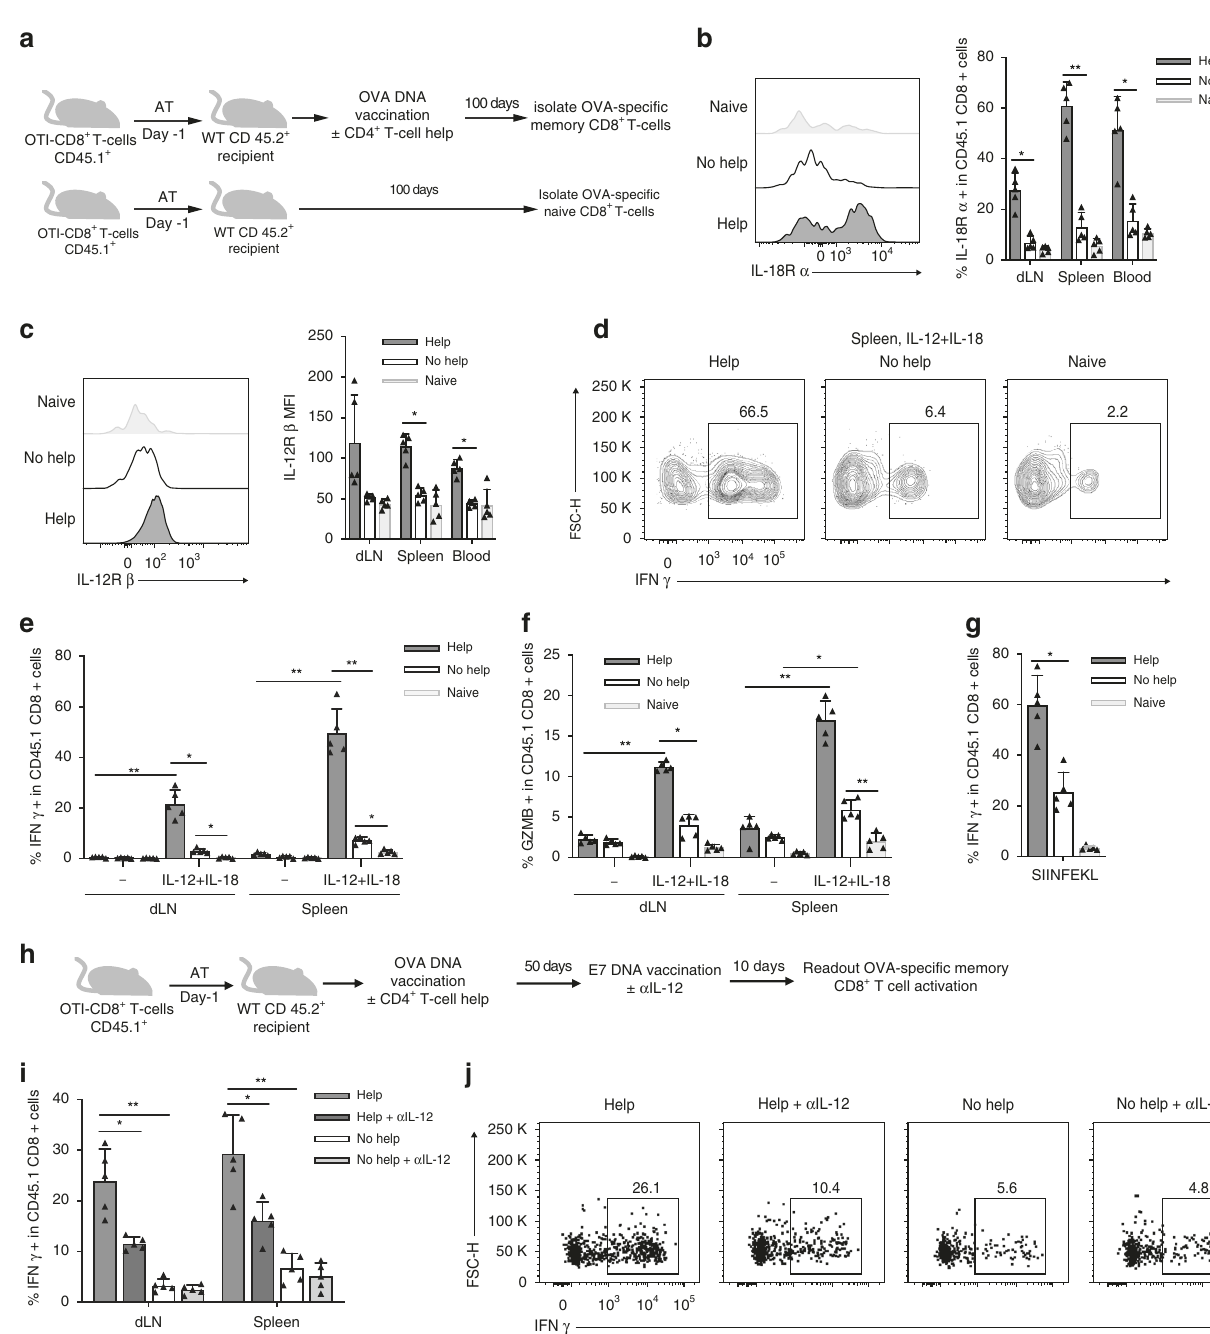
Fig. 4 CD4 + T cell help promotes innate recall function of memory CD8 + T cells. a Experimental set up. CD45.1 + OT-I T cells were adoptively transferred into CD45.2 + recipient mice ( n = 5 per group) that 1 day later received OVA-encoding Help or No Help pDNA vaccine. At day 100 after primary vaccination, fl ow cytometry was performed in blood and CD45.1 + OT-I T cells were fl ow cytometrically isolated from dLN and spleen and directly analyzed or incubated for 5 h with IL-12 and IL-18 or OVA peptide. Unvaccinated recipient mice were used to isolate naïve OT-I T cells. b Representative fl ow cytometric plots (left panel) and percentage of IL18-R α expressing cells within CD45.1 + OT-I cells in indicated organs (right panel). c Representative fl ow cytometric plots (left panel) and MFI of IL-12R β expressed on CD45.1 + OT-I T cells in indicated organs (right panel). d – g Primary fl ow cytometric data ( d ) and frequencies of IFN γ -producing ( e , g ) or Granzyme B (GZMB)-producing ( f ) OT-I T cells in dLN and spleen, as determined after in vitro stimulation with IL12 + IL-18 (D-F) or OVA peptide (SIINFEKL) ( g ). h Experimental set up. CD45.1 + OT-I T cells were adoptively transferred into CD45.2 + recipient mice ( n = 5 per group) that 1 day later received OVA-encoding Help or No Help pDNA vaccine. At day 50 after primary vaccination, mice were rechallenged with E7-encoding Help vaccine and injected with isotype control or neutralizing mAb to IL-12, 4 times, every 3 days. At day 10 after secondary vaccination, total dLN and spleen cells were incubated for 5 h with GolgiPlug (no cytokines or antigens were added). i Frequencies of IFN γ -producing CD45.1 + OT-I T cells isolated from indicated organs. j Representative fl ow cytometric analysis of cells isolated from spleen. Data are from one experiment representative of two experiments. Error bars indicate SD, * p < 0.05, ** p < 0.01, *** p < 0.001 (unpaired two-tailed Student ’ s t test). Source data are provided as a Source Data fi